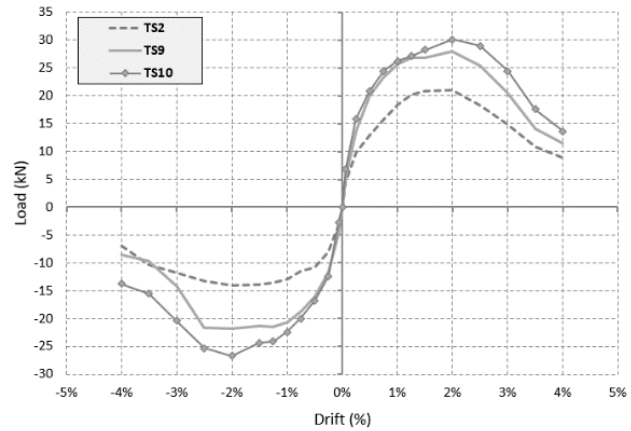
Figure 13. Load–drift skeleton curves deriving from cyclic tests.